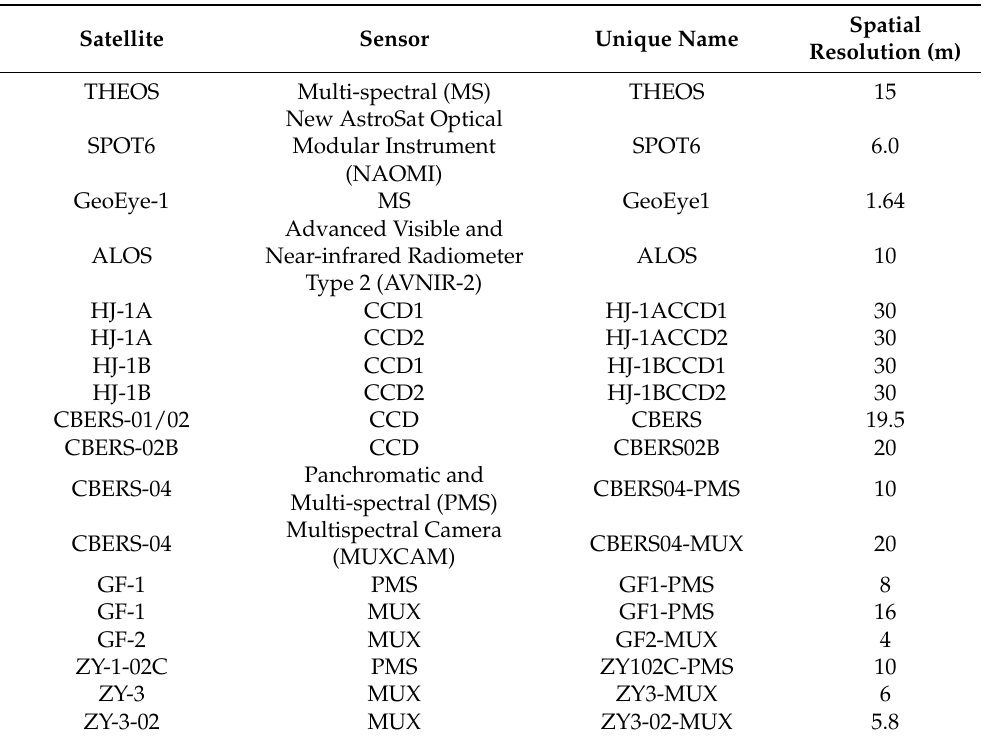
Table 3. Unique sensor names and spatial resolutions for satellites and sensors from which LSR products are retrieved.